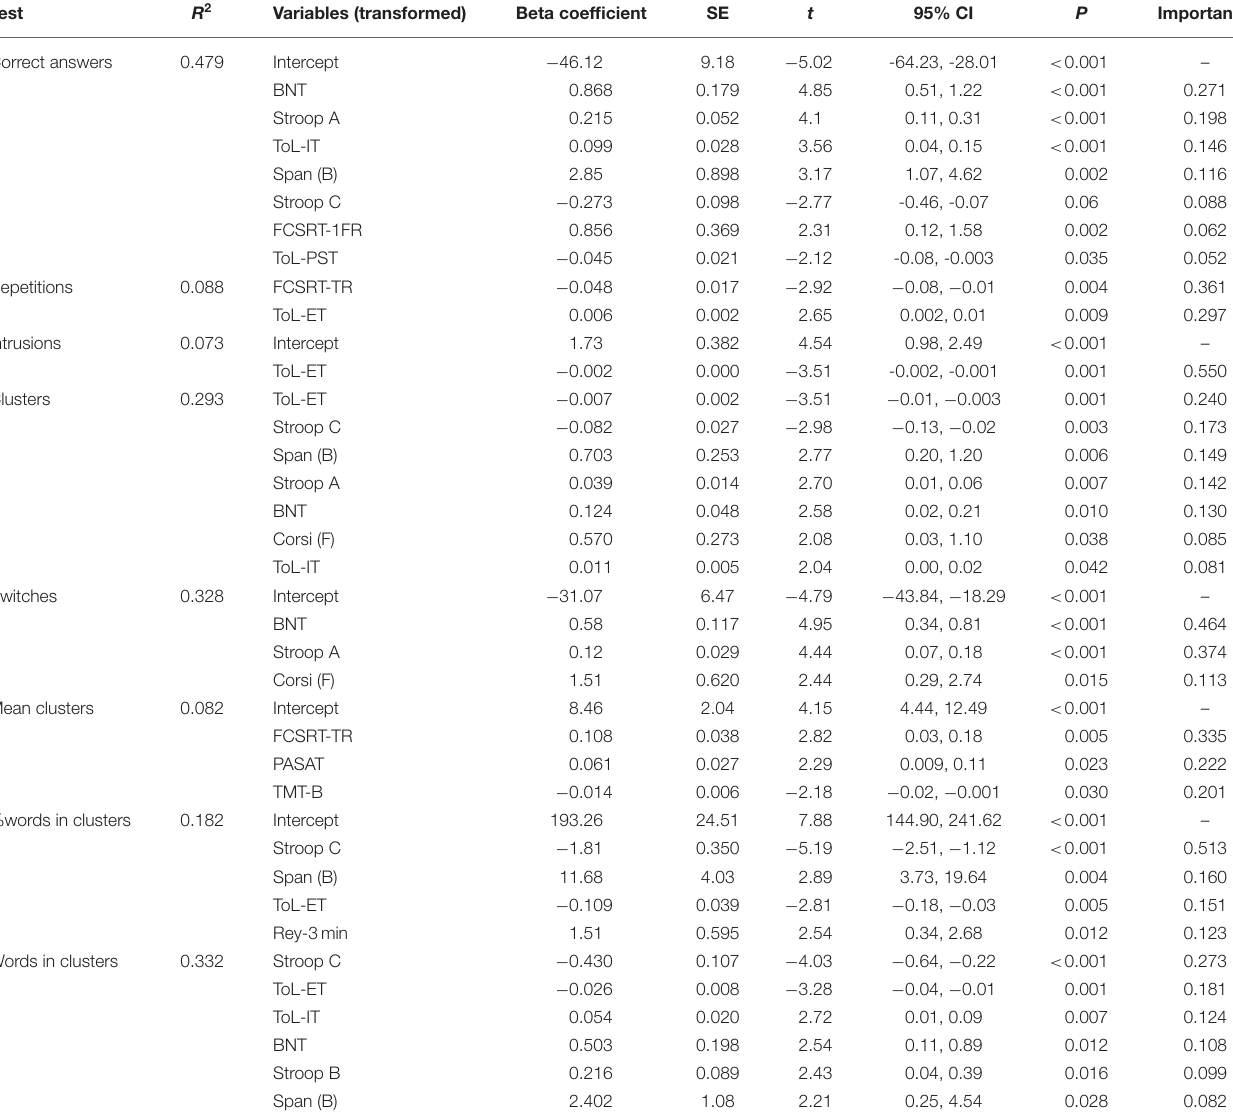
TABLE 5 | Automatic linear modeling assessing the neuropsychological predictors of phonemic fluency (p, r, m).